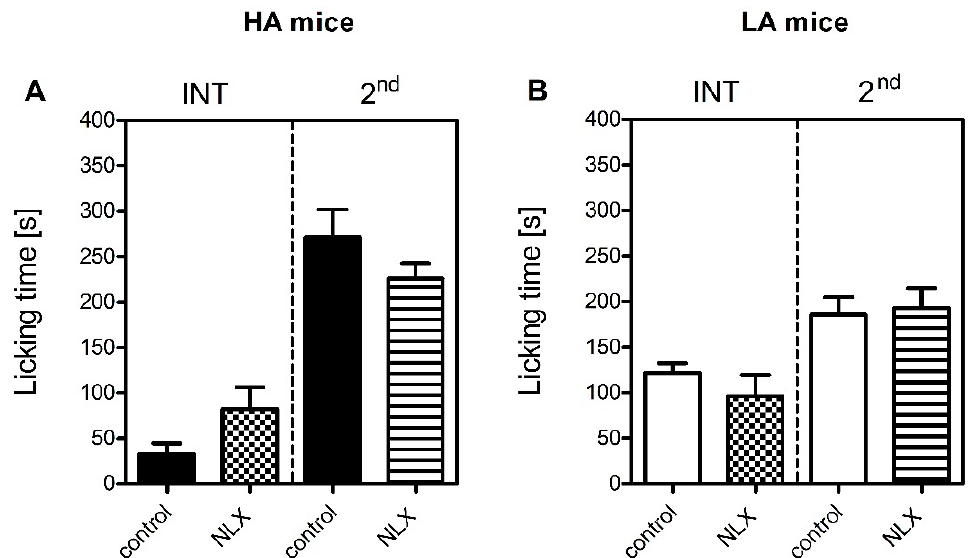
Figure 2. The effect of naloxone (1 mg/kg, i.p., NLX) on acute inflammatory pain sensitivity in HA ( A ) and LA ( B ) mice ( n = 8–10) in the formalin test upon injection of 5% formalin (in PBS) into the dorsum of the hind foot. Paw licking time was measured in the interphase (INT, 5–20 min) and the second phase (2nd, 20–60 min) of the test. NLX was administered 15 min prior to formalin. Results were analysed within each line and phase with two-way and one-way ANOVA followed by Bonferroni’s post-hoc test. No statistical significance was observed.